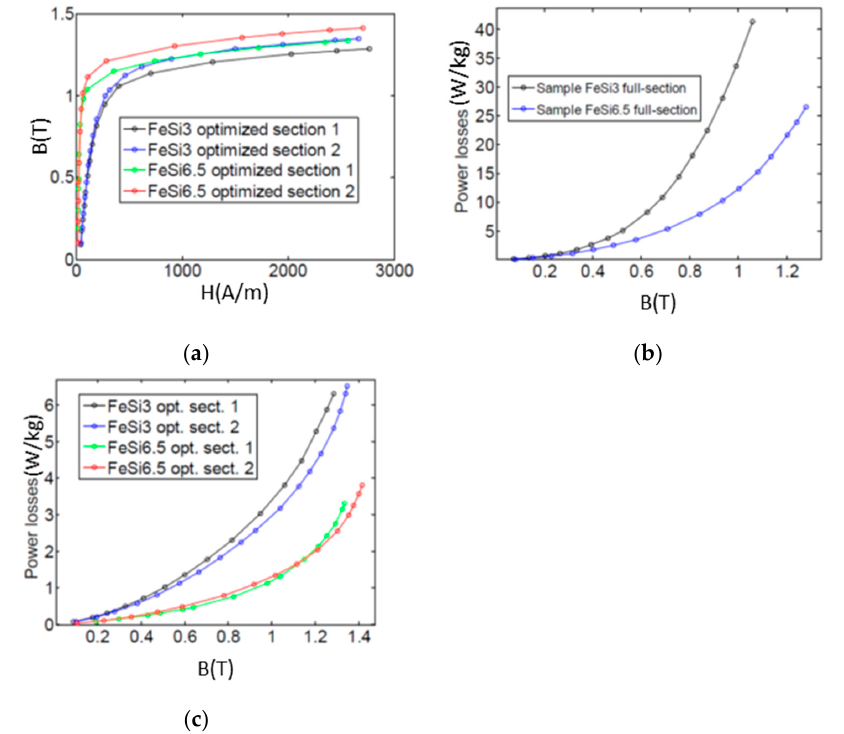
Figure 14. ( a ) Anhysteretic curves of the samples with optimized sections; ( b ) power losses of the samples with full-section; ( c ) power losses of the samples with optimized sections.